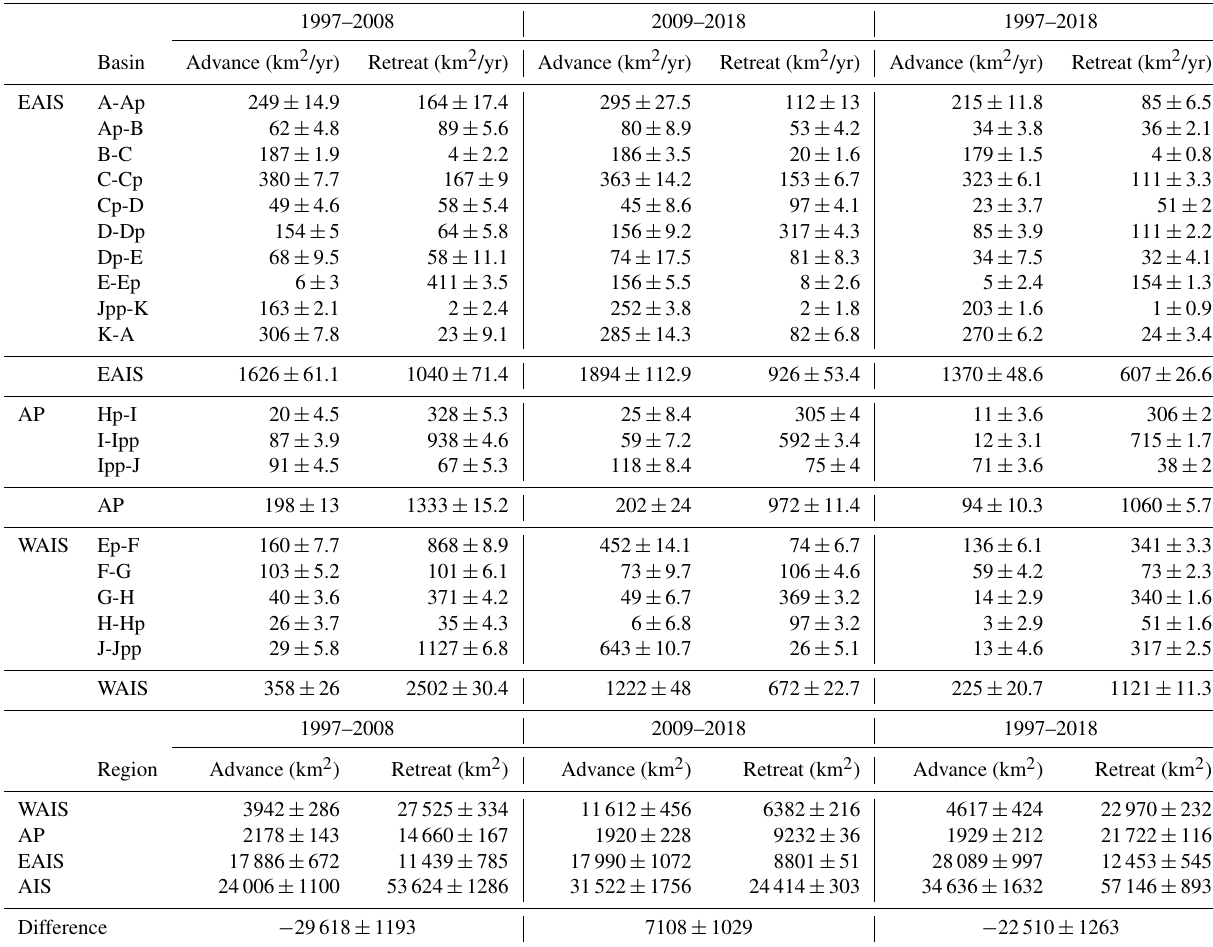
Table 2. Retreat and advance rates of Antarctic glaciers and ice shelves for each basin between 1997 and 2018 (upper table). Total lost and gained ice shelf or glacier area per decade (lower table). For basin abbreviations see Fig.